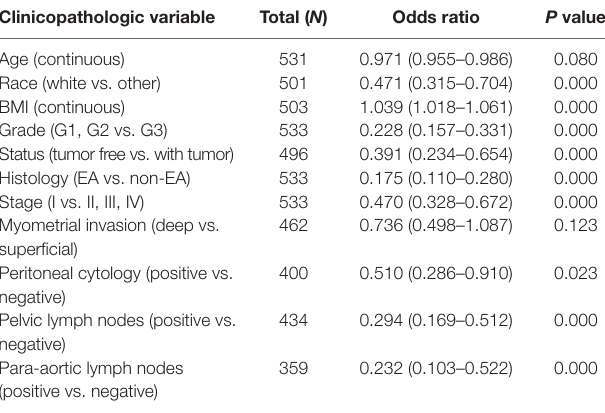
TABLE 4 | Univariate miR-497 expression* association with clinicopathologic characteristics (logistic regression). Clinicopathologic